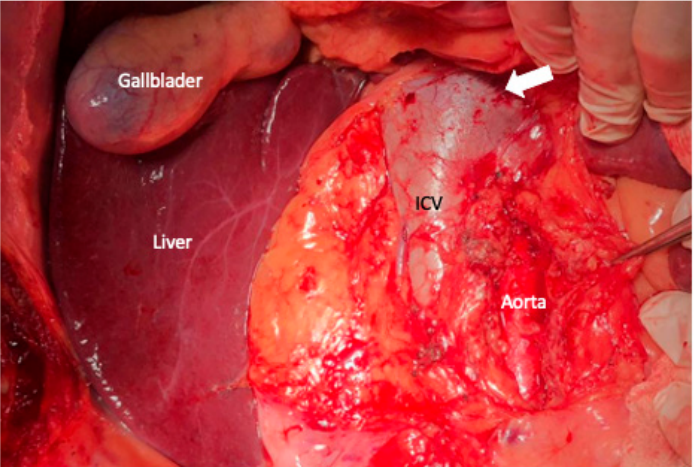
Figure 2. In extensive Kocher maneuver in combination with the Cattell–Braasch mobilizations of the cecum, right colon, right colonic flexure, and the root of the small bowel, together with the Treitz ligament, an adequate exposure of the entire infrahepatic vena cava (IVC), aorta, and the left renal vein (white arrow) is